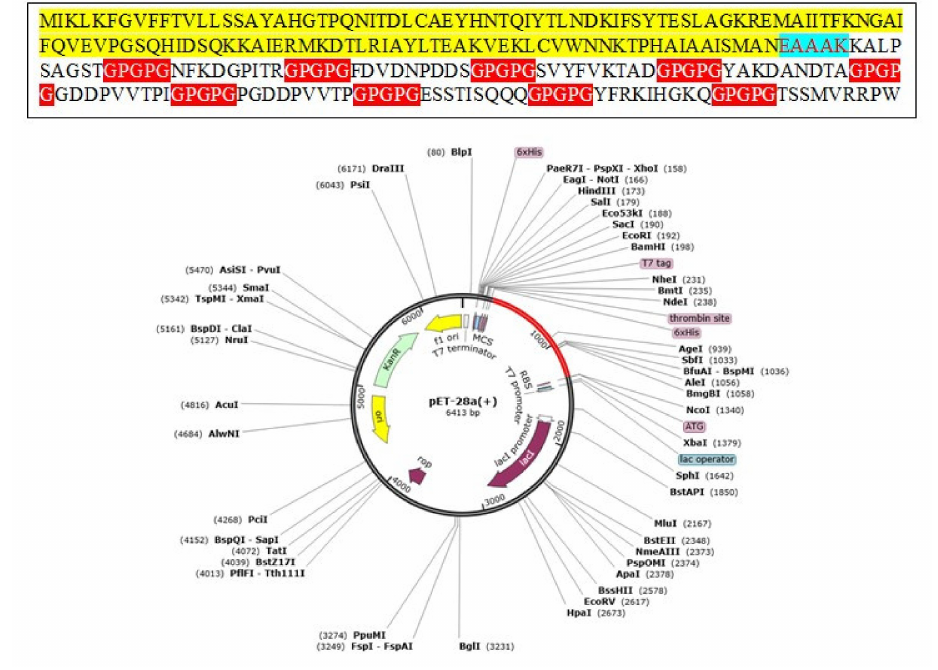
Figure 7. Cloning of multi-epitope vaccine constructs computationally into pET28a (+) vector. The vaccine is shown in red